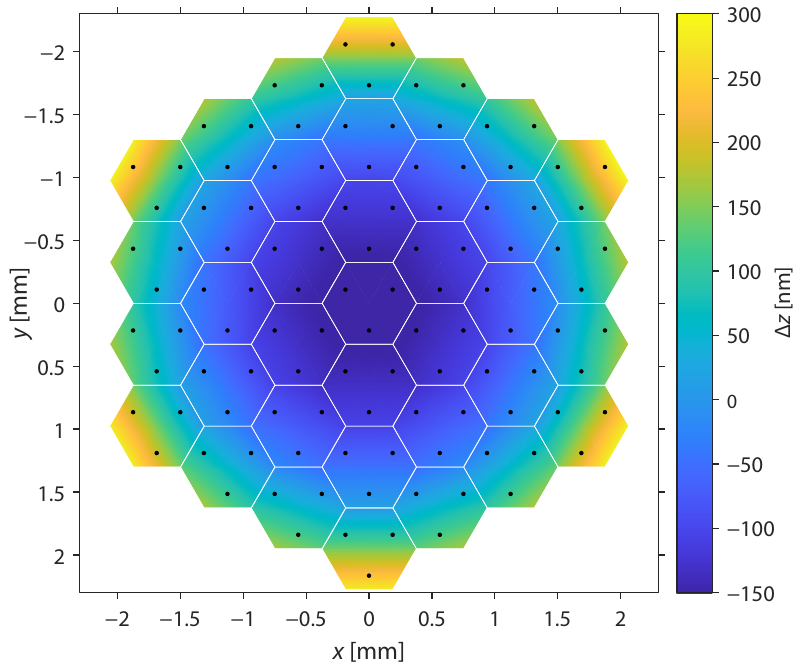
Figure 7. Average shape at equal command voltages for all actuators of the deformable